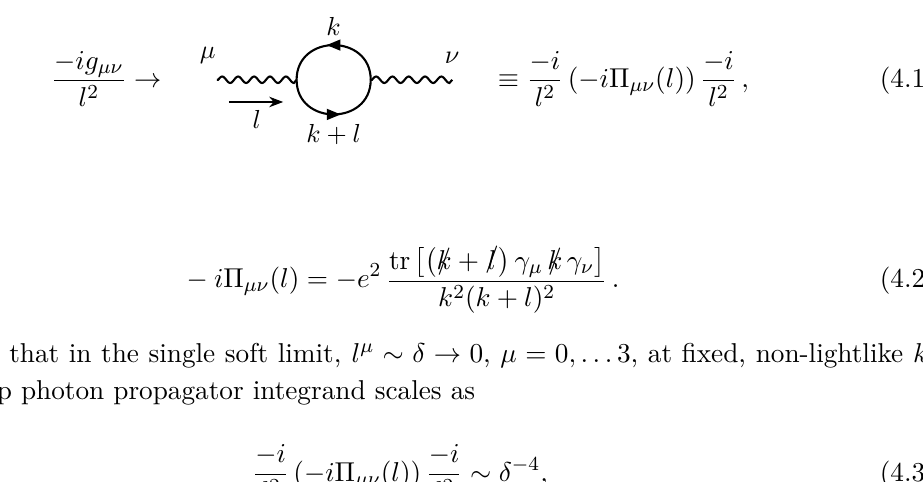
with a photon vacuum polarization sub-